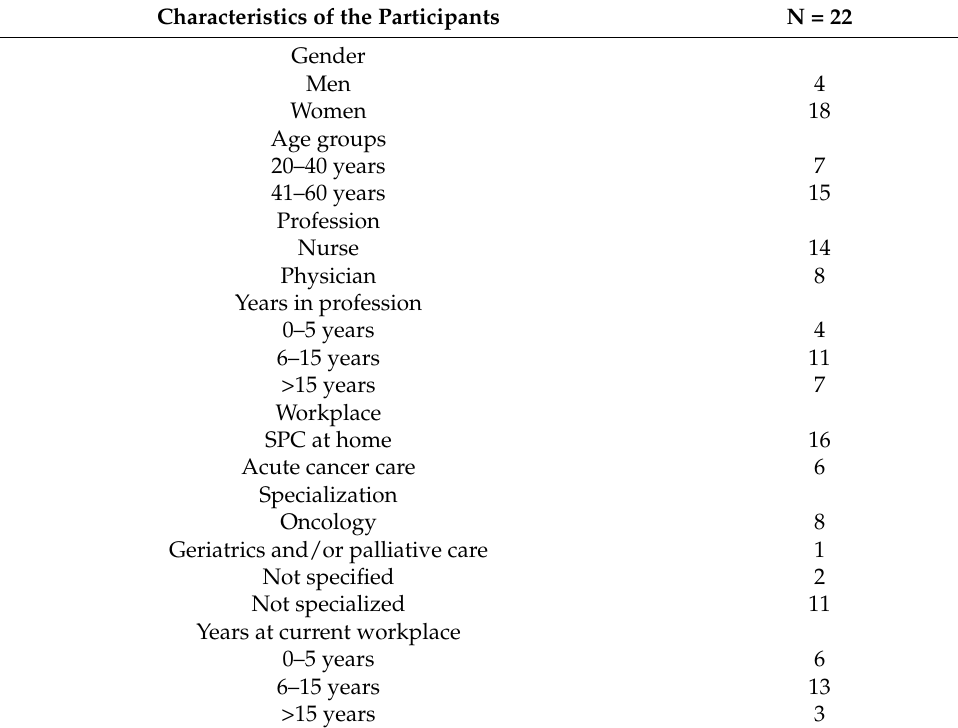
Table 1. Characteristics of participants in the focus